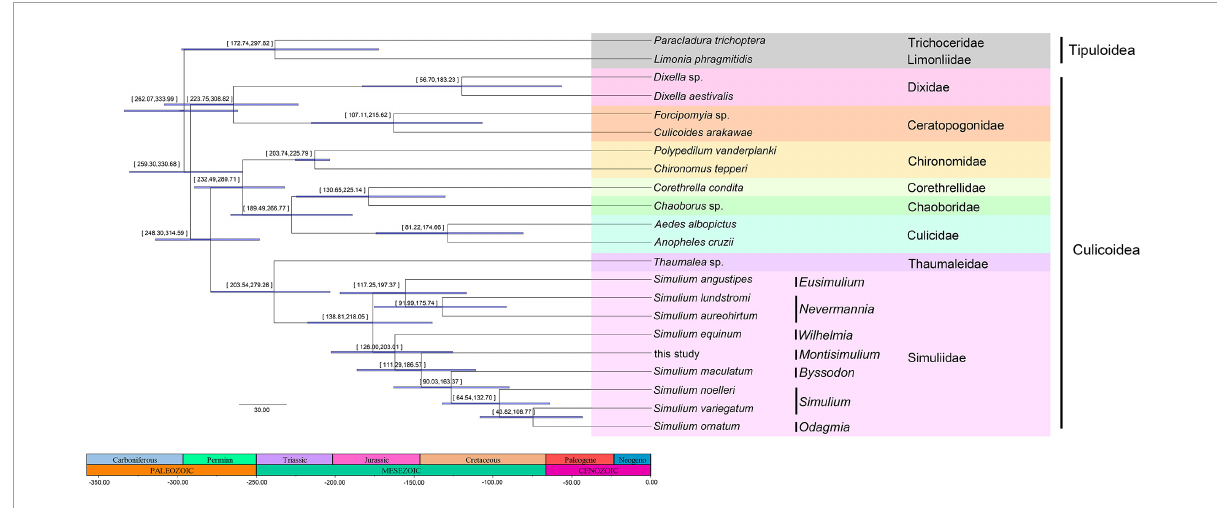
FIGURE8 Estimated divergence times among all families based on PhyloBayes